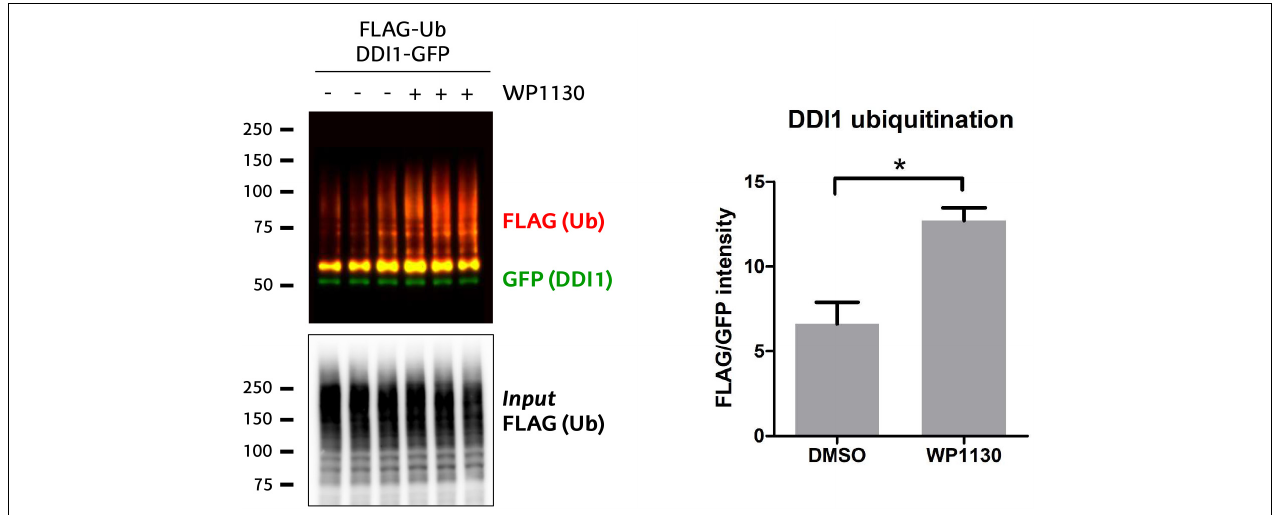
FIGURE 6 | USP9X inhibition by WP1130 enhances DDI1 ubiquitination. Cells expressing GFP-DDI1 and FLAG-Ub were treated with 5 µ M WP1130 or DMSO for 1 h. GFP-DDI1 was pulled down and its ubiquitination monitored by western blot. Anti-GFP antibody was used to detect unmodified GFP-DDI1 levels whereas anti-FLAG antibody was used to detect ubiquitination. The signal of FLAG was normalized to the GFP signal. Equivalent amount of transfected ubiquitin was detected in the cell lysates by measuring FLAG-Ub levels [ Input FLAG-(Ub)]. Quantification using Image-J showed a statistically significant increase in DDI1 ubiquitination after WP1130 treatment [ t -test, ∗ p -value < 0.05, (mean ± S.E.M., n = 3)].